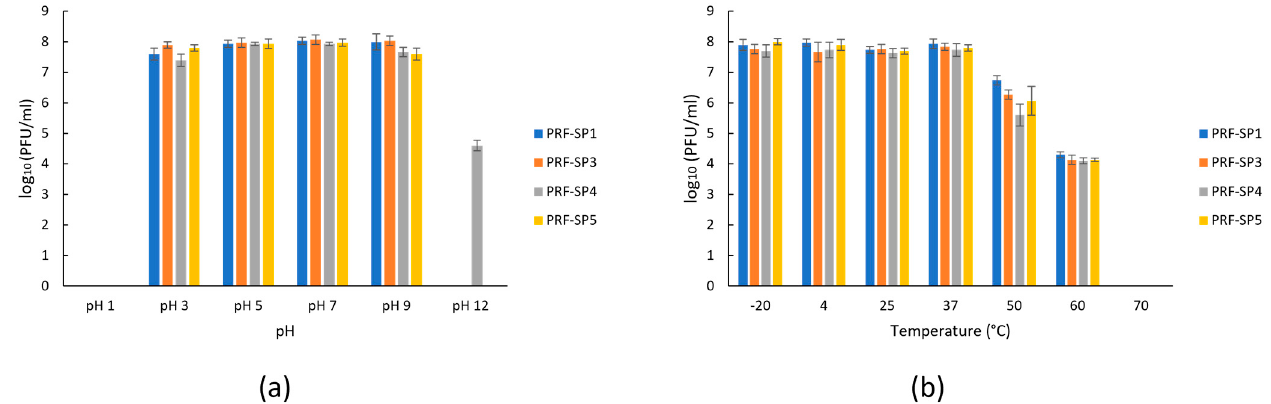
Figure 2. Stability profiles of phages over a range of pH and temperatures. ( a ) pH stability profile, ( b ) Thermal stability profile. Error bars indicate standard deviation among triplicate samples.